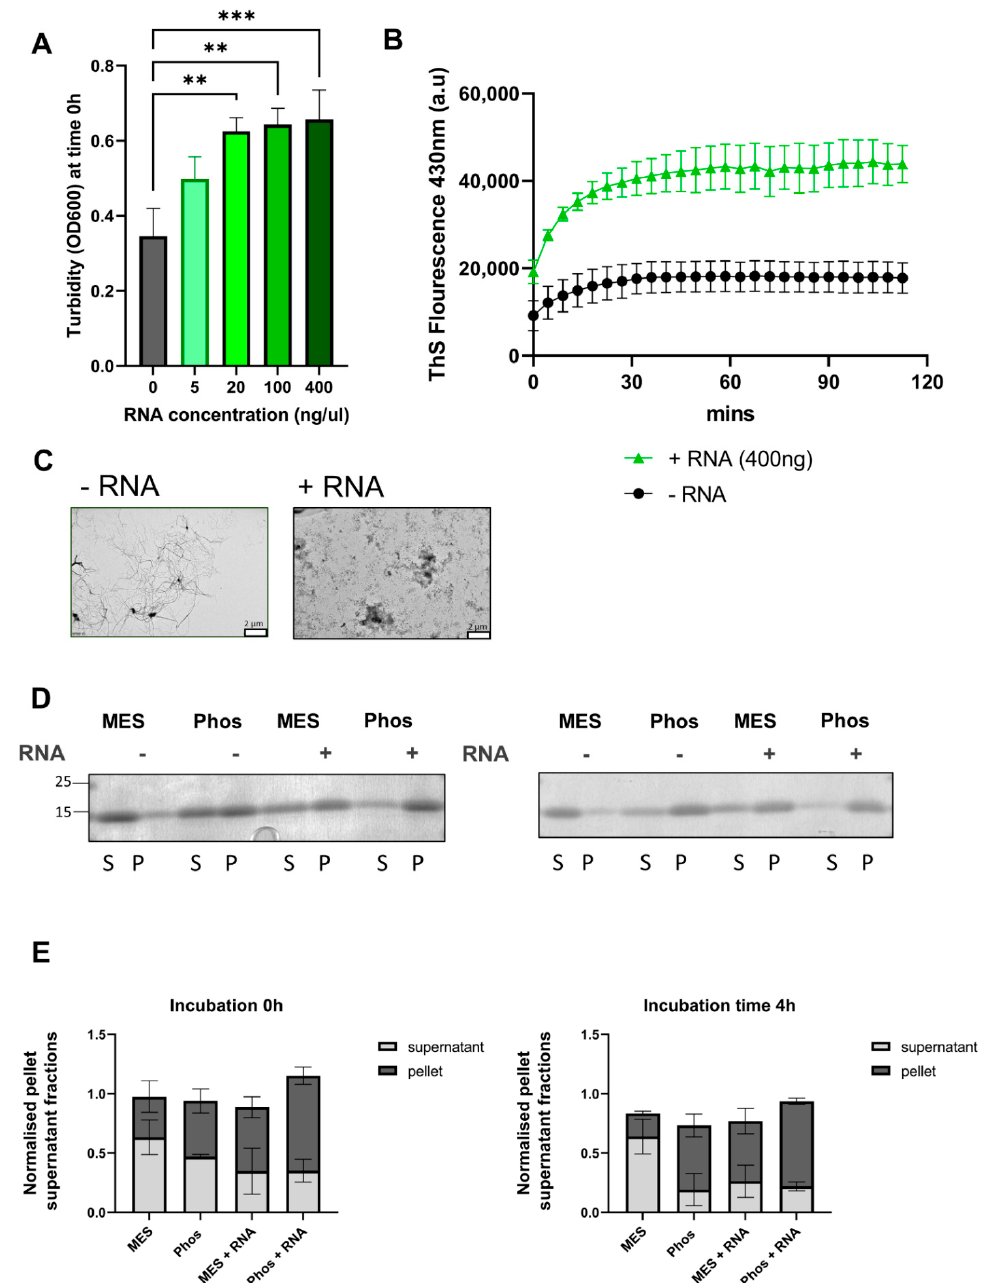
Figure 6. RNA increases the aggregation behavior of the TDP-43 LCD. ( A ) Addition of total yeast RNA increases the turbidity of 20 µ M TDP-43 LCD in LLPS+ (phosphate buffer 50 mM) buffer; n = 3 mean ± SD is shown with one-way ANOVA with a Holm–Š í d á k multiple comparisons test used to determine significant differences. ** p ≤ 0.01 and *** p ≤ 0.001 ( B ) Addition of 400 ng/ µ L yeast RNA leads to a higher and faster ThS aggregation readout. ( C ) Using EM of samples of 1-week-old protein, (+/-) RNA shows two very different morphologies after addition of 400 ng of yeast RNA to TDP-43 LCD. Fibrillar morphology associated with RNA– condition. Scale bar 2 µ m. ( D ) The levels of TDP-43 LCD in the supernatant (S) and pellet (P) with (+) and without RNA (-) in LLPS+ (phosphate buffer) and in LLPS- (MES buffer) was measured using Coomassie staining. The left Coomassie stain is for 0 h of incubation of protein and RNA, and the right one is after an incubation period of 4 h of protein and 400 ng/ µ L of RNA. ( E ) The quantification of the intensity of the bands on the Coomassie gel is shown below the blots and indicates that more TDP-43 LCD is in the pellets in the liquid–liquid phase separating conditions; n = 3; mean ± SD is